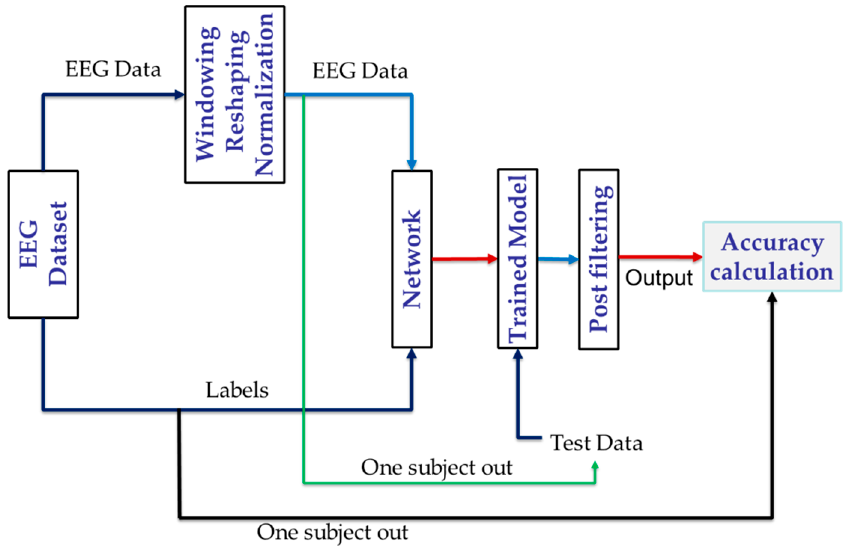
Figure 5. Overall training and testing process of the EEG-based emotion recognition model.